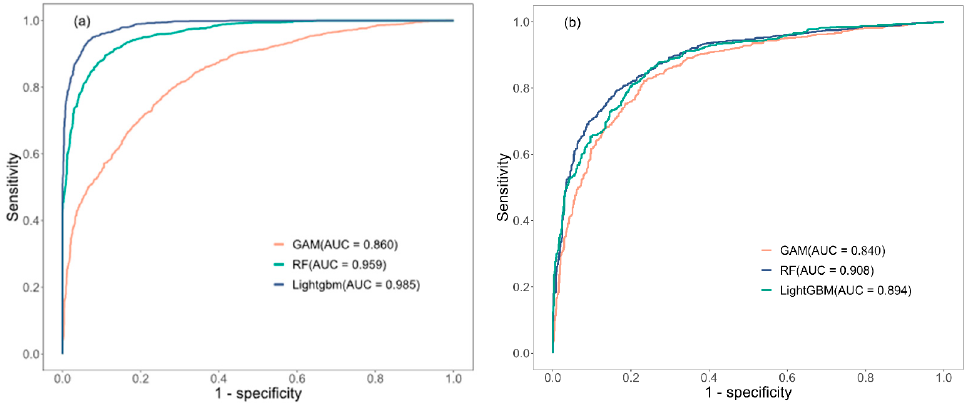
Figure 4. ( a ) The ROC of the training set and ( b ) the ROC of the validation set.